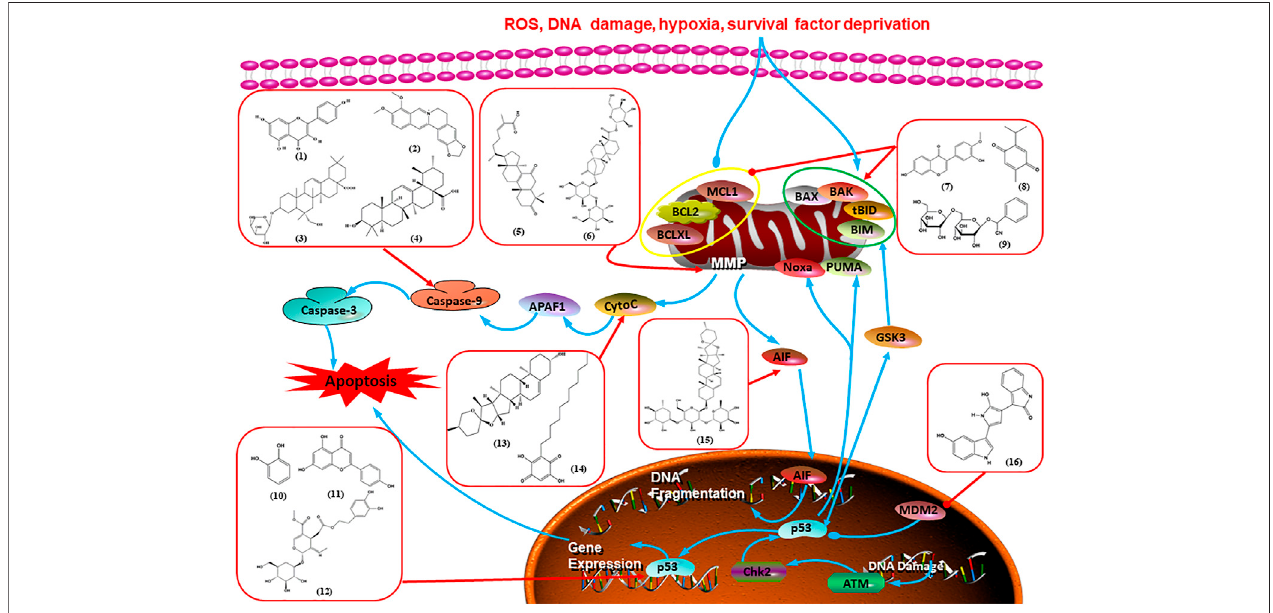
FIGURE 1 | Natural products induced apoptosis through mitochondrial pathway. (1) Kaempferol, (2) berberine, (3) Clematis hederagenin saponin, (4) ursolic acid, (5)ganodericacidDM,(6)stevioside,(7)Calycosin,(8)thymoquinon,(9)amygdalin,(10)catechol,(11)apigenin,(12)oleuropein,(13)diosgenin,(14)embelin,(15)dioscin, (16) violacein.